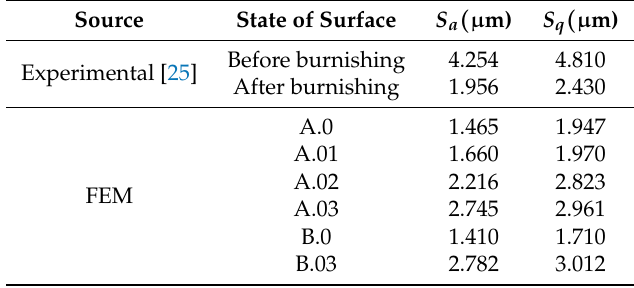
Table 6. Surface amplitude descriptive parameters for the experimental surfaces and surfaces derived from the five FEMs. Source State of Surface S a ( µ m) Before burnishing